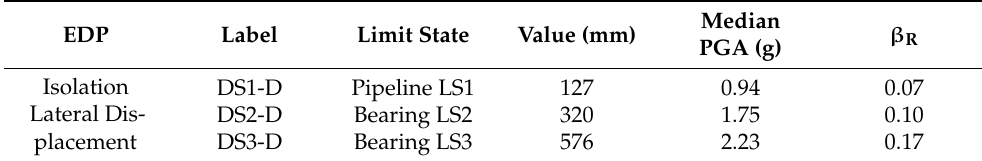
Table 5. IDA results for the lateral displacement EDP.